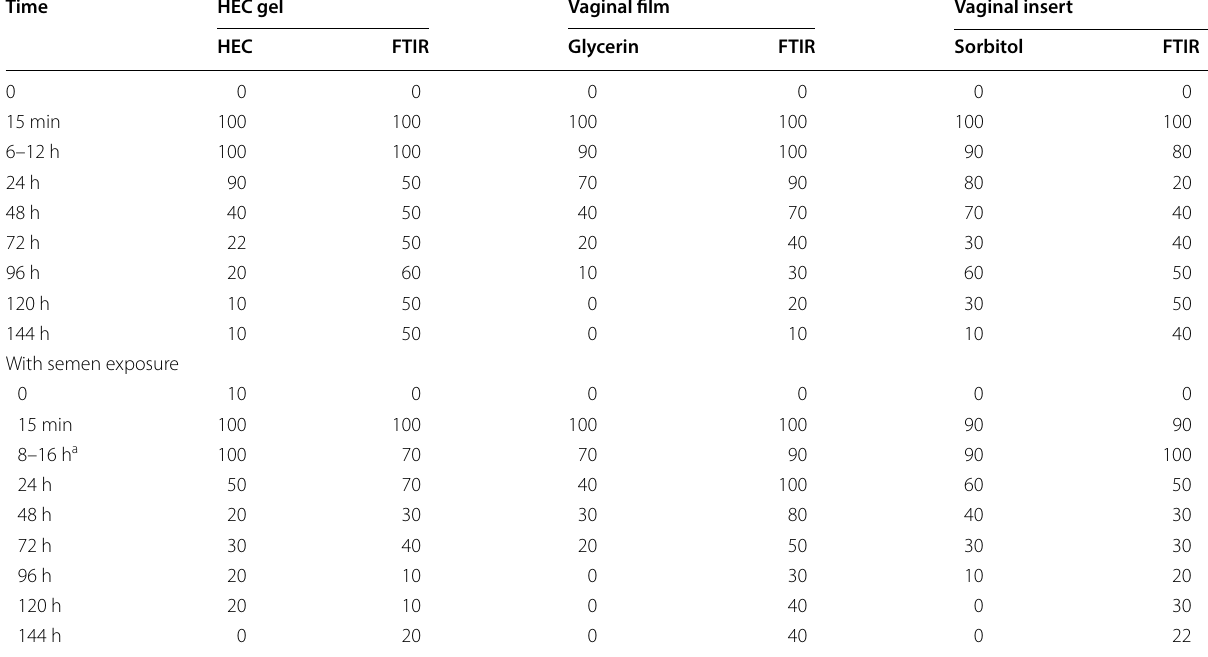
Table 6 Placebo product detection in vaginal swabs of the 135 Study